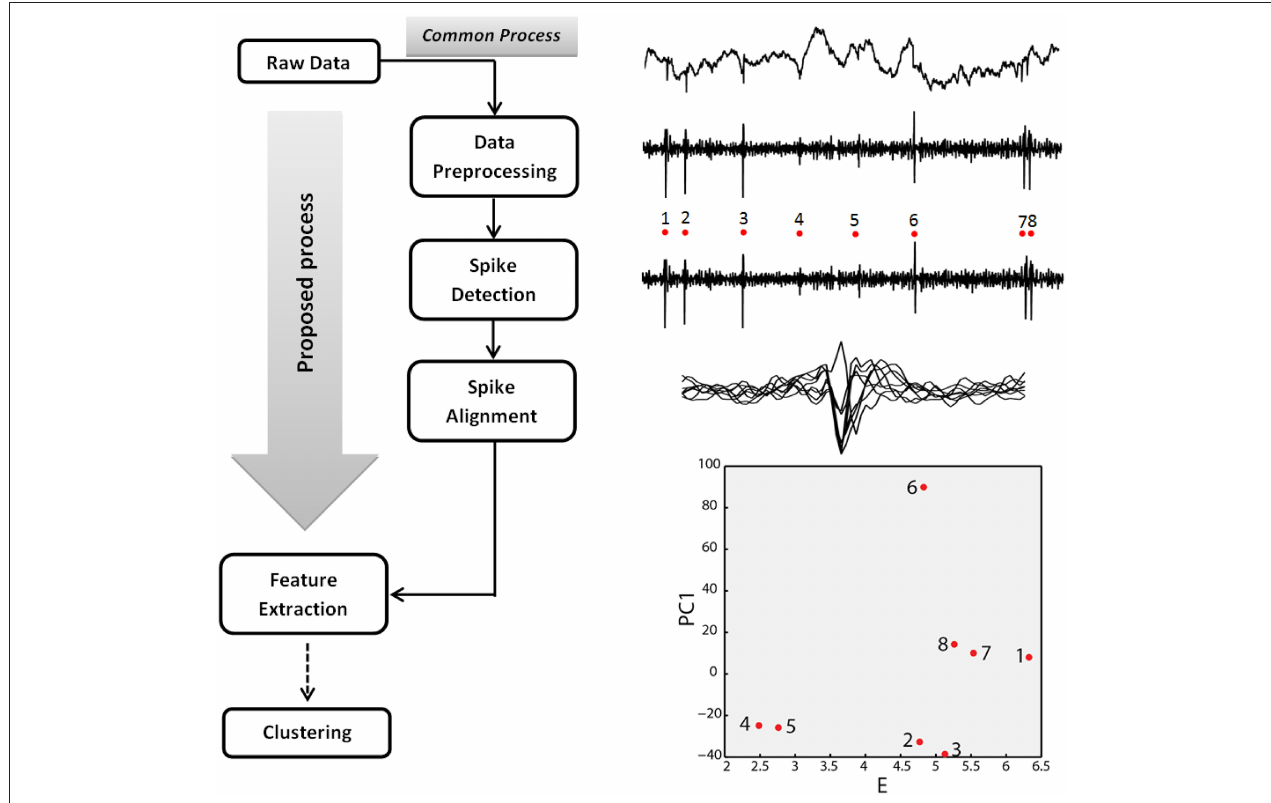
FIGURE 1 | Spike sorting process. Left, common and proposed spike sorting processes. Right, Step-by-step illustration of the spike sorting process using part of the 533101 session signal of the real extracellular recordings dataset ( Henze et al., 2009; recording channel 3, samples 30501–34000). The depicted example of feature space corresponds to the energy (E) of the aligned spike waveform (abscissa) and the first principal component coefficient (PC1) of the energy normalized spike waveform ( Schmitzer-Torbert et al., 2005; ordinate). Spikes 1, 7, and 8 correspond to the same neuron (Henze et al., 2009; intracellularly recorded